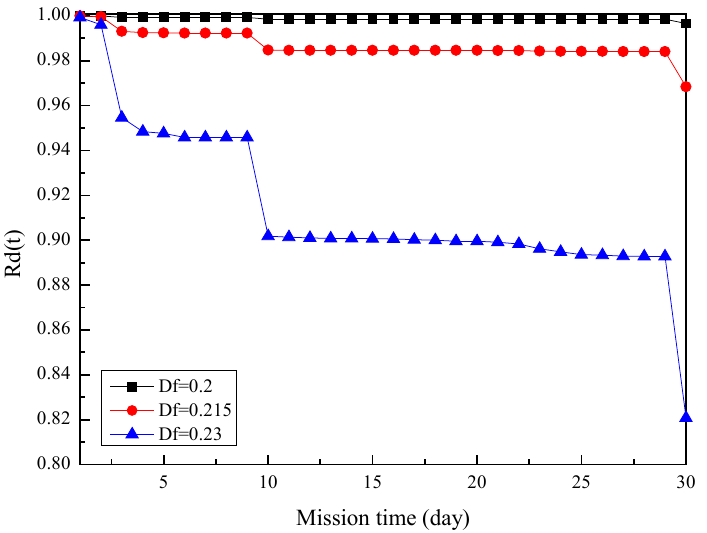
Figure 9. The reliability for the degradation failure under different threshold levels.